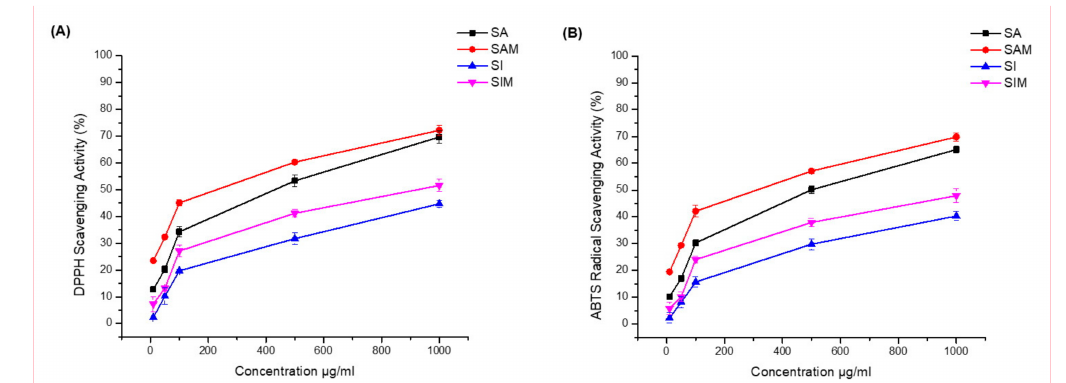
Figure 4. Antioxidant activities of SA, SI, SAM, and SIM. ( A ) 2-diphenyl-1-picrylhydrazyl (DPPH) scavenging activity of SA, SI, SAM, and SIM; ( B ) 2,2 (cid:48) -azino-bis (3-ethylbenzothiazoline-6-sulfonic acid) (ABTS) scavenging activity of SA, SI, SAM, and SIM. Data were analyzed using Origin Pro 8